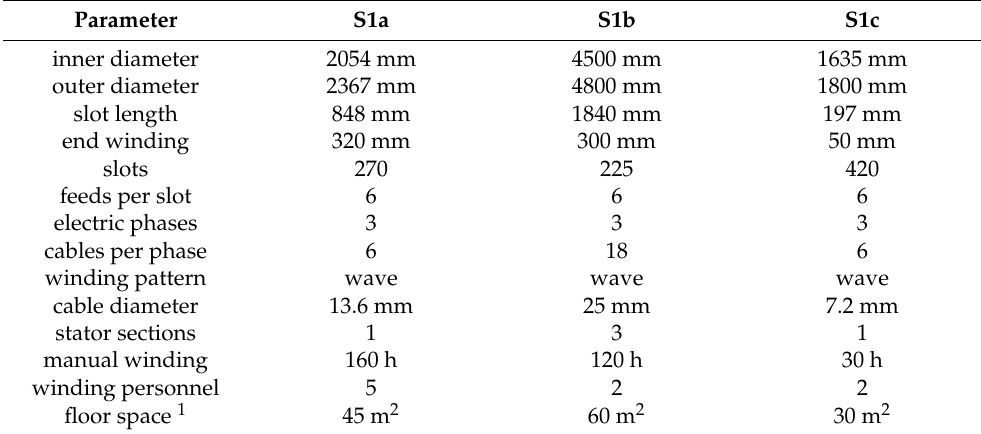
Figure 2. The renewable energy conversion generators used as examples of a medium–large rotating cable wound electric machine in this paper: The wind energy generator S1a ( left ), photo from [39], a stator section from wind energy generator S1b ( middle ), photo from Vertical Wind AB, and the hydrokinetic energy generator S1c ( right ), photo from [42]. Table 1. Geometric and winding characteristics for S1a–c.